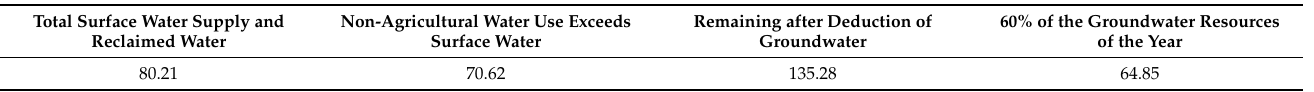
Table 5. Agricultural water consumption in Lancang County under the assumption of non- agricultural priority use of surface water in 2021.